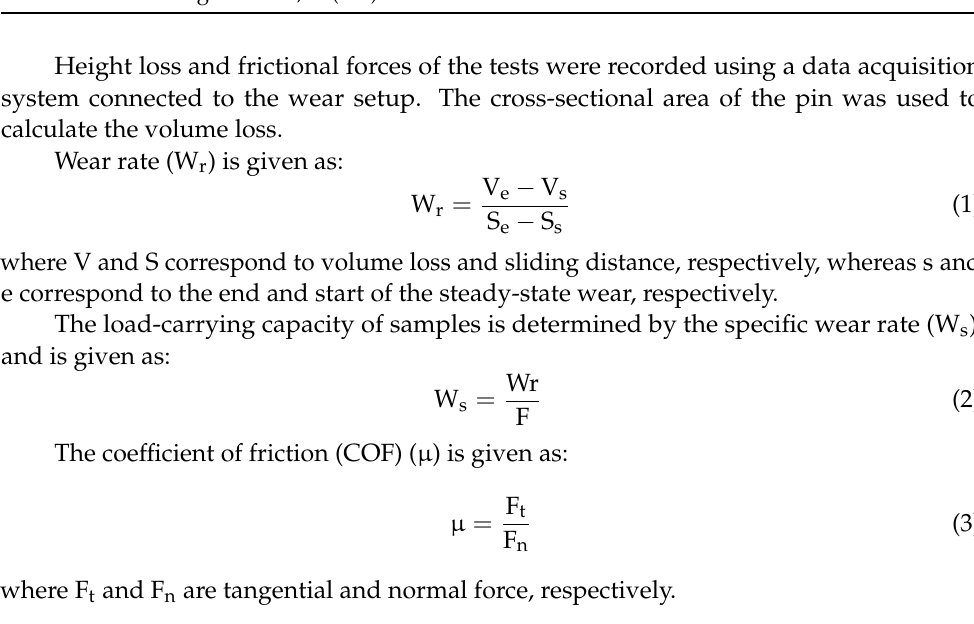
Figure 2. Dry sliding wear experimental setup [5]. Table 2. Levels of dry sliding wear parameters used in the study. Parameters Level 1 Level 2 Level 3 Filler content, (Vol.%) 10 20 30 Load, F (N) 30 40 50 Sliding distance, D (km) 1 3 5